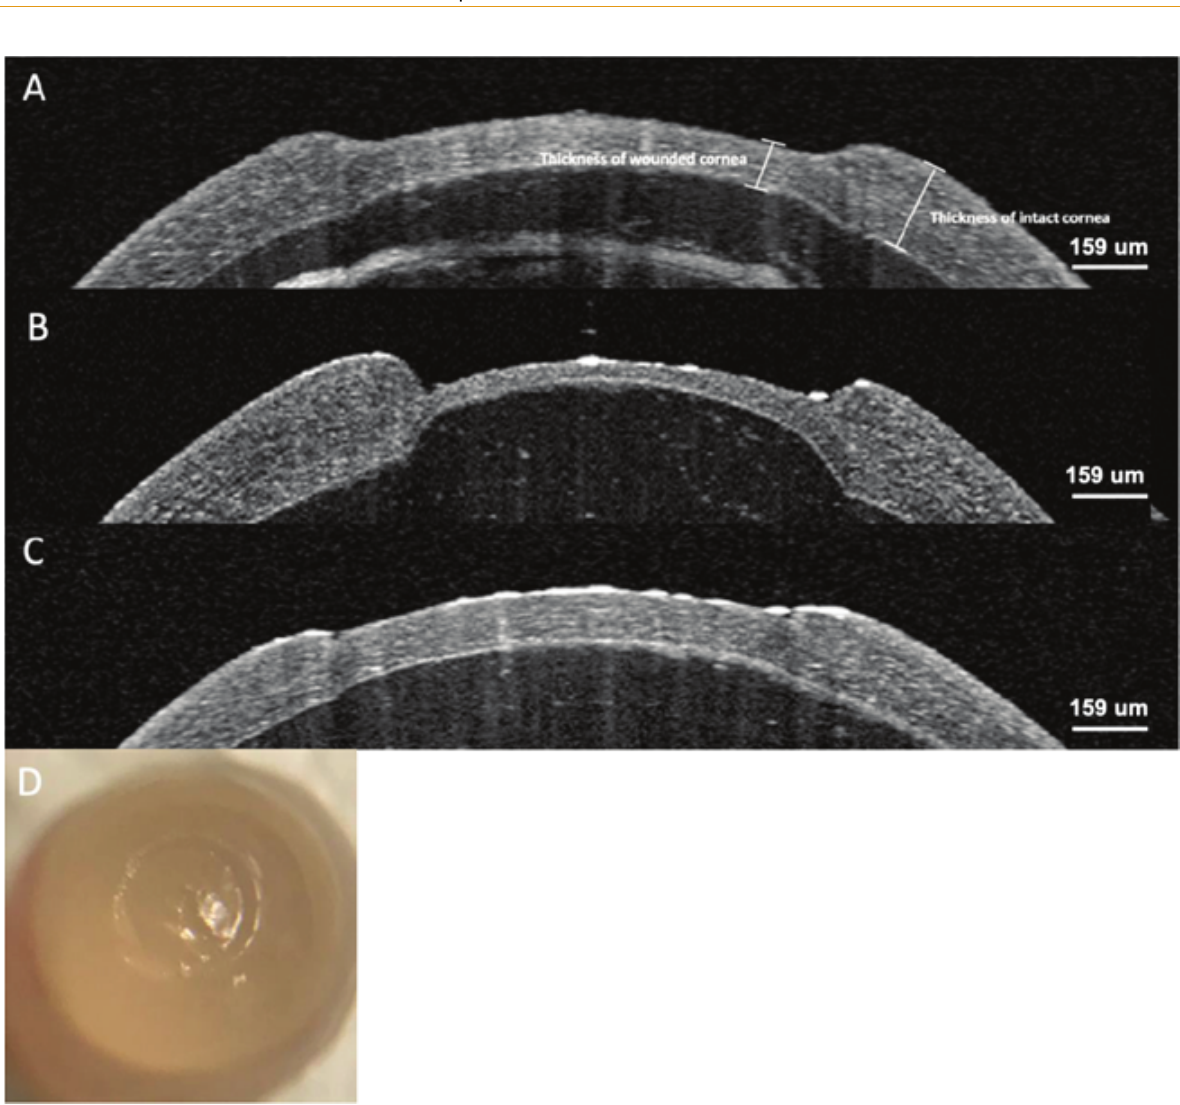
Figure 2. Optical coherence tomography (OCT) of the rat corneas after ALK. (A) Intermediate defect of the cornea. (B) Deep defect of the cornea. (C) Superficial defect of the cornea. (D) Rat eyeball after ALK with the inner-stopper guarded trephine.